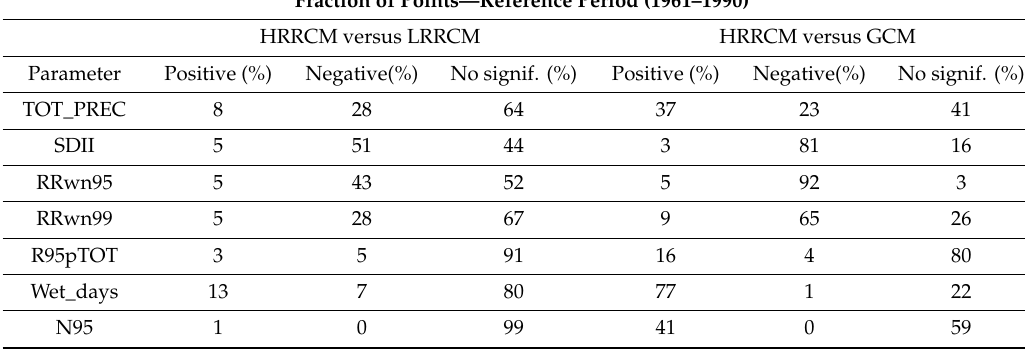
Table 2. Fraction (percent, %) of points with positive, negative and non-significant di ff erences of the low-resolution simulation (LRRCM) and the global simulation (GCM)with respect to the high-resolution simulations (HRRCM). Each line refers to a di ff erent indicator (see Section 2.2). Values refer to the reference period 1961–1990. The columns positive / negative denote points where the HRRCM is significantly higher / lower than the other